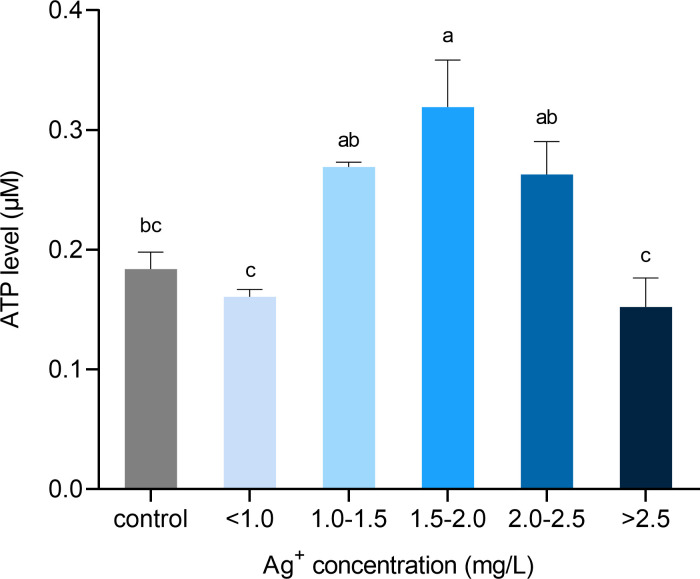
Quantification of intracellular ATP content from cells exposed to different concentrations of silver ions for 21 hours.Calculation of cellular ATP by interpolating standard curve values in a luminescent microplate assay. Values were normalized to living cell number. Means ± SEM. a, b, c, d = different superscripts denote statistically significant differences in ATP values between samples (P < 0.05). Experiments were repeated four times.